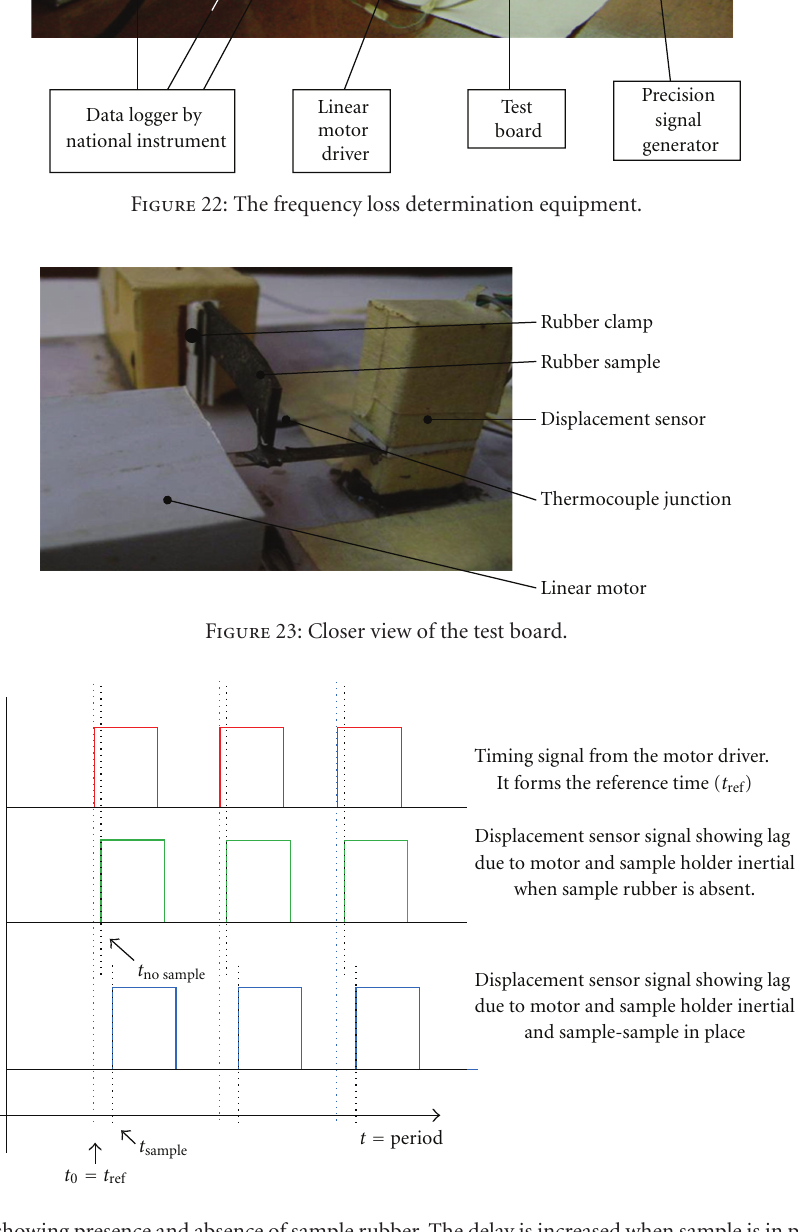
Figure 24: Signal pattern showing presence and absence of sample rubber. The delay is increased when sample is in place. The absolute value of this delay is obtained from t sample − t no sample − t ref